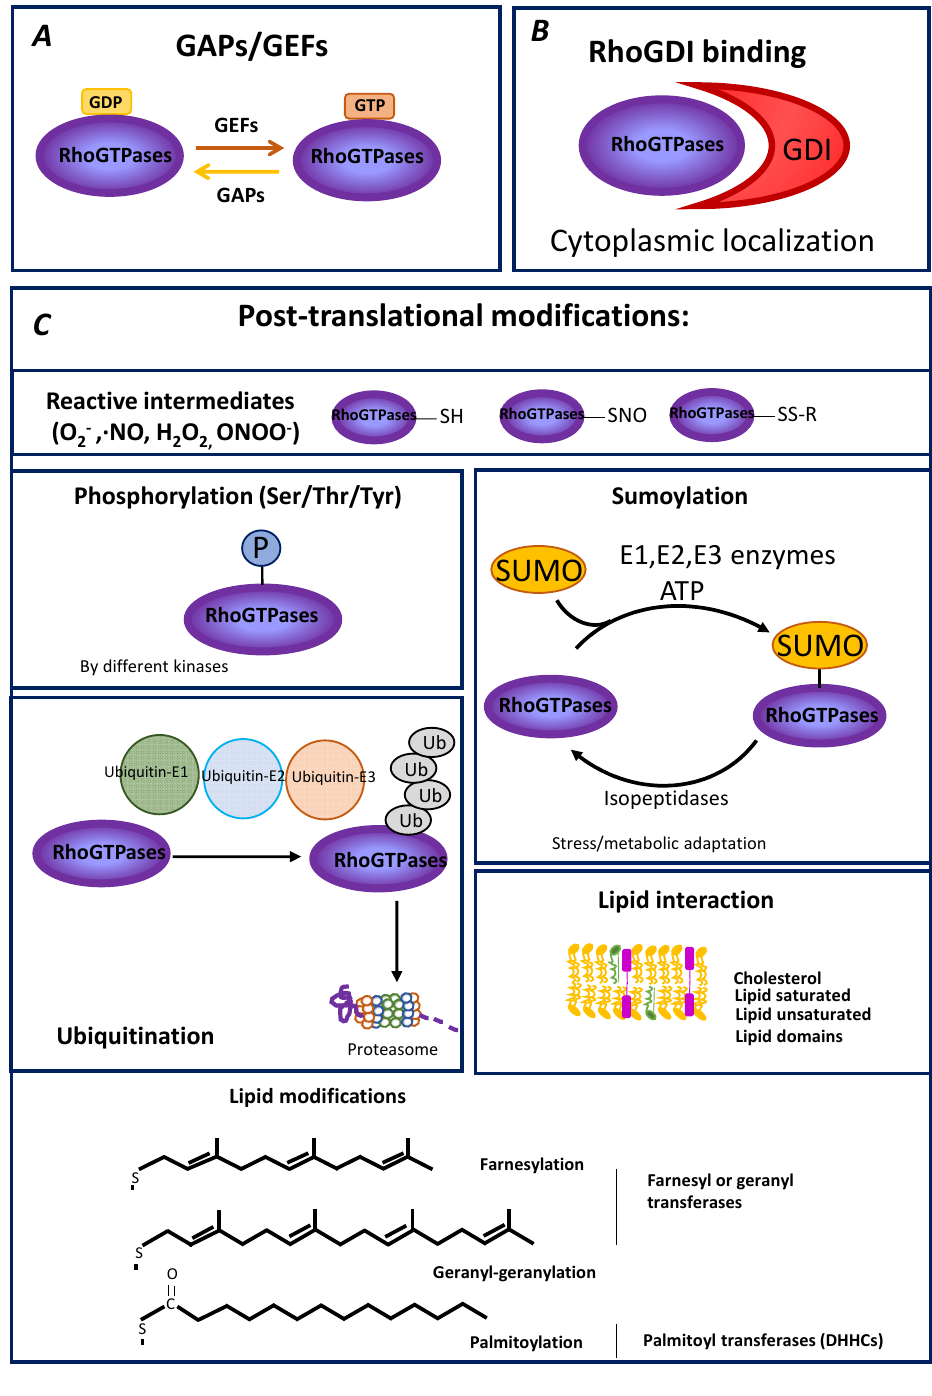
Figure 1. Mechanisms forRho GTPase modulation. ( A , B ) GAPs and GEFs ( A ) and GDI ( B ) constitute primary regulation layers controlling GTPase activity through the dynamics of GDP–GTP cycling and the sequestration from membrane environments, respectively. ( C ) Different types of non-mutually exclusive post-translational modifications modulating small GTPase localization and/or activity are summarized. (SUMO: Small Ubiquitin-like Modifiers).